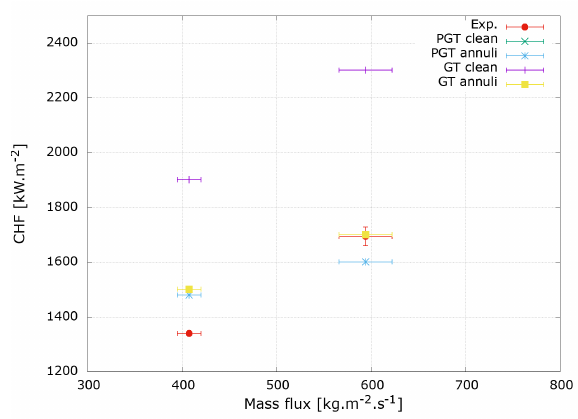
Figure 9. Comparison of CHF results against calcu- lations with PGT correlation and Groeneveld’s tables at p in = 220 kPa and T in = 78 ℃.